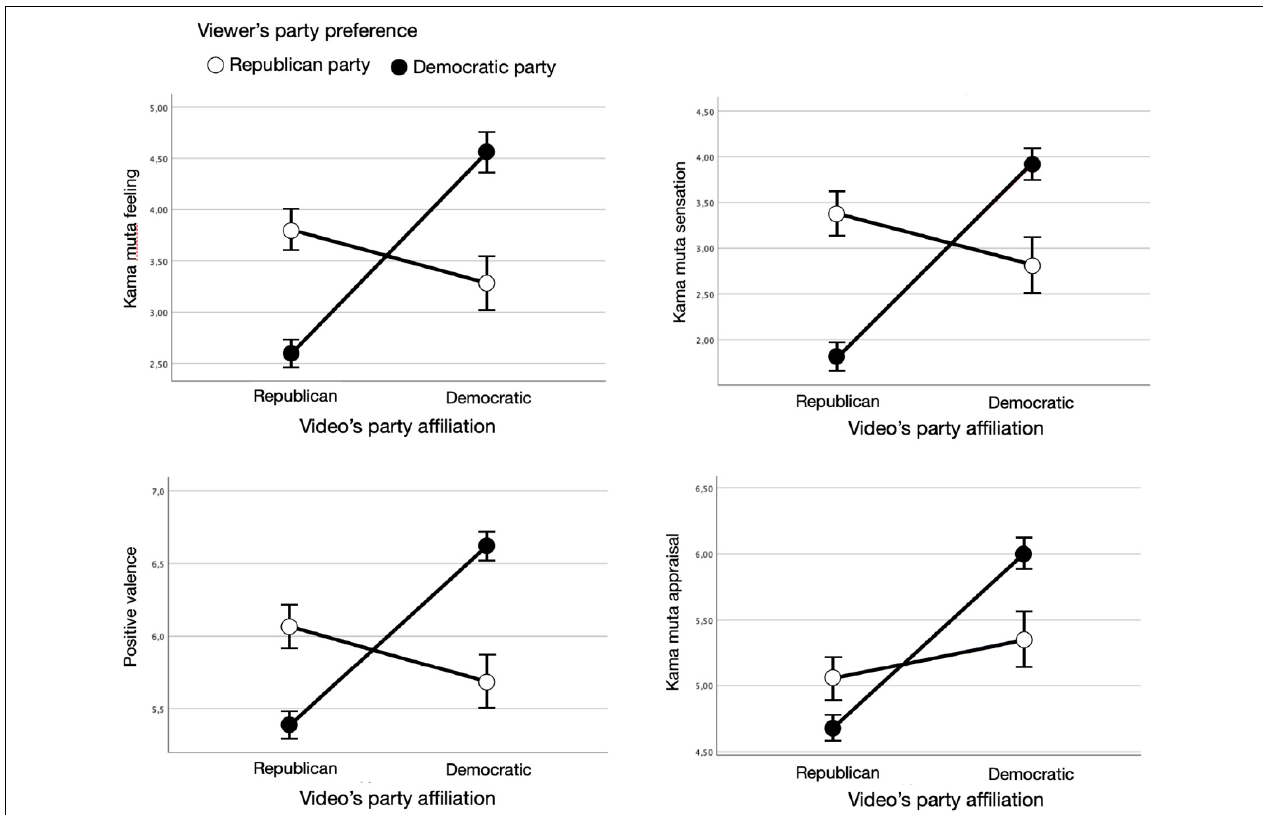
FIGURE 1 | Interaction effects of video’s party affiliation and viewer’s party preference on the four components of kama muta: feeling, sensation, positive valence, and